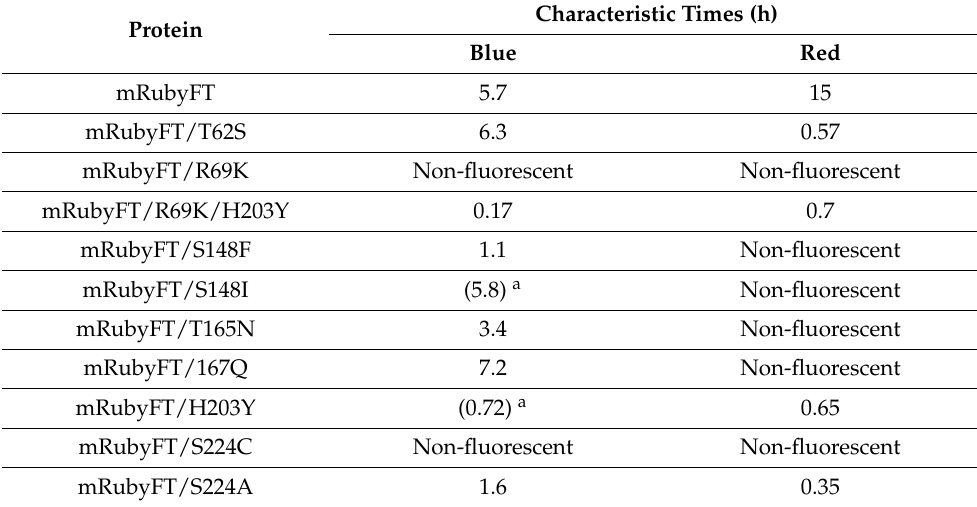
Table 3. In vitro characteristic times for blue and red forms of the purified mutants of mRubyFT timer. a corresponds to half-time, not maximum, because fluorescence of the blue form reached a plateau. Characteristic Times (h) Protein Blue